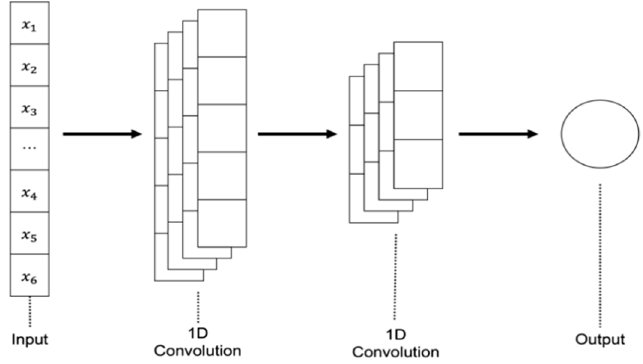
Figure 6. The structure of the 1D-CNN model.